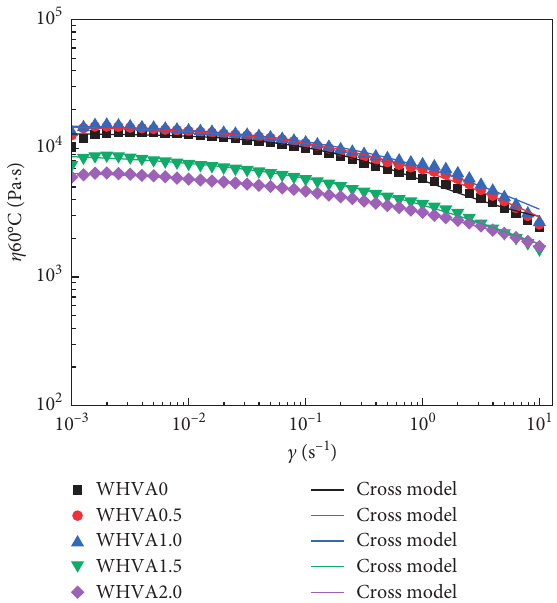
Figure 6: Flow curves of warm-mix HVA at 60 ° C as a function of WMA content. Table 2: The resulting Cross model parameters as a function of WMA content for warm-mix HVA. Various WMA contents (wt.%)